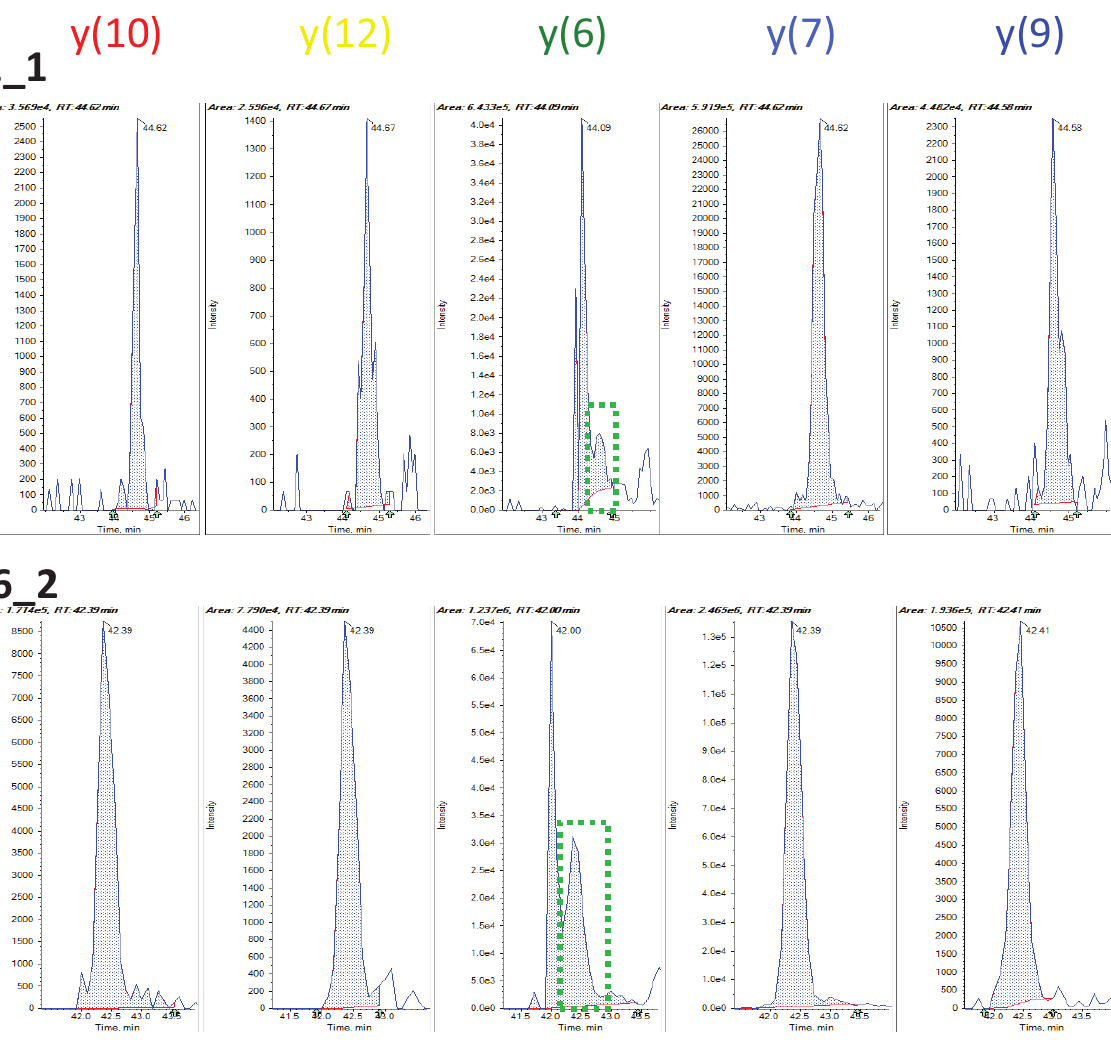
Figure 5. Interquartile region of transition peak weights for transitions with median weight >0.9 and <0.9 for ( a ) PSD data and ( b ) Cysteine string protein (CSP)